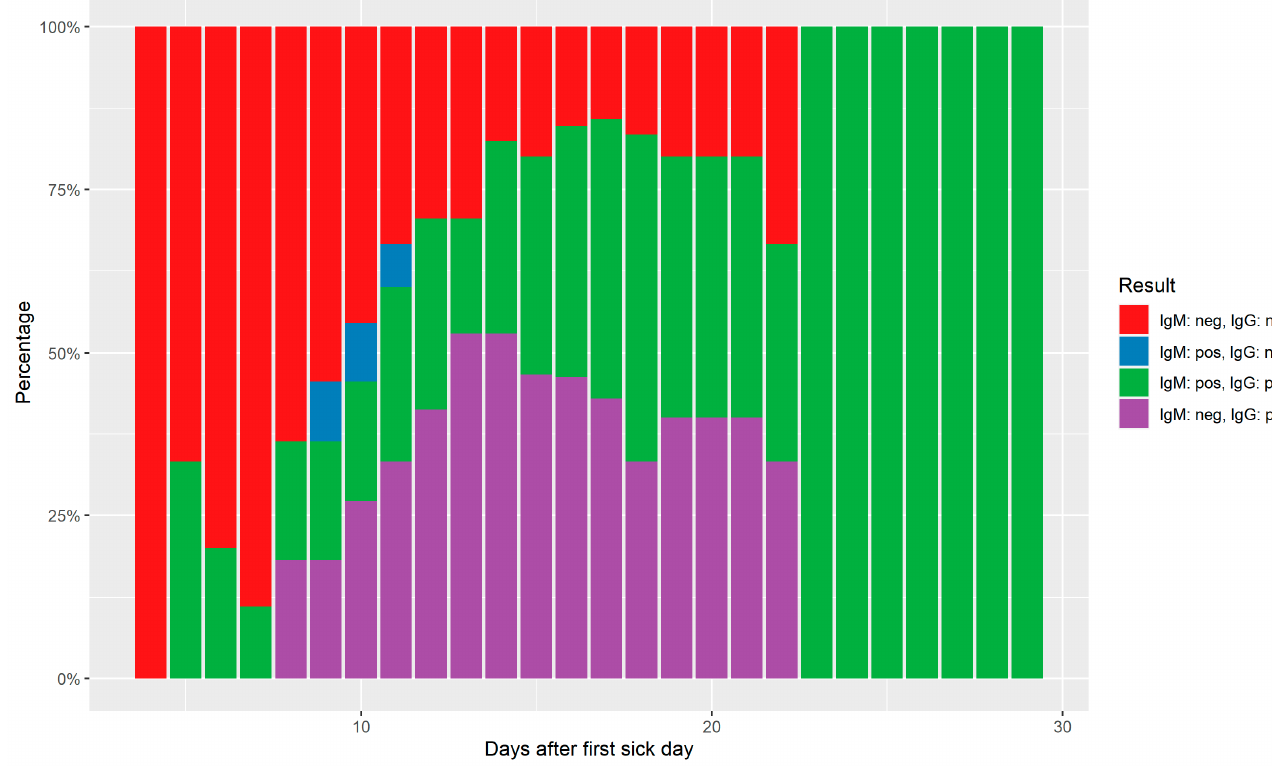
Figure 2. Relative aggregated sequential serological results over time.